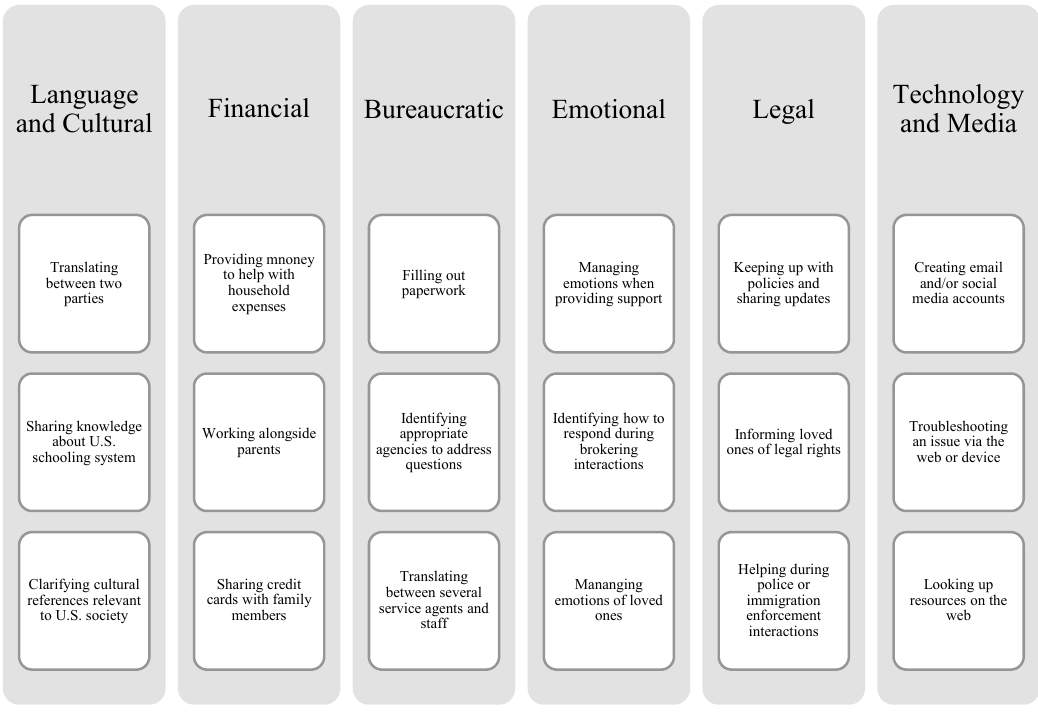
Figure 1. Dimensions and examples of young people’s care work in immigrant